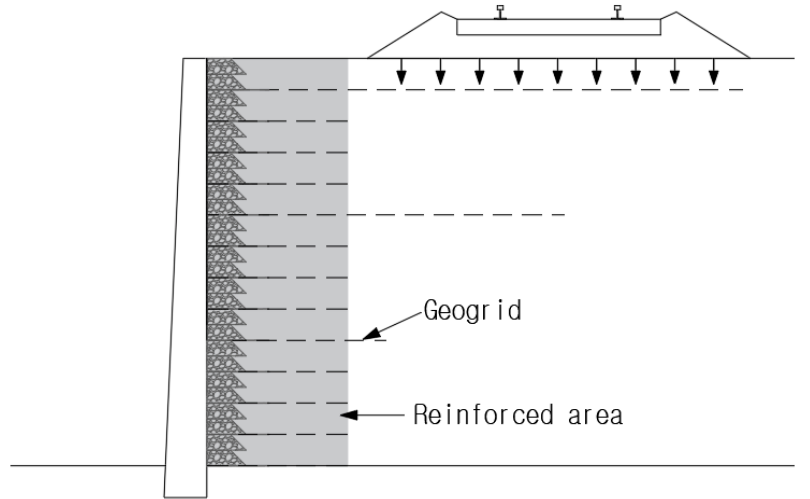
Figure 1. Overburden load acting outside the reinforcement area of RSR.